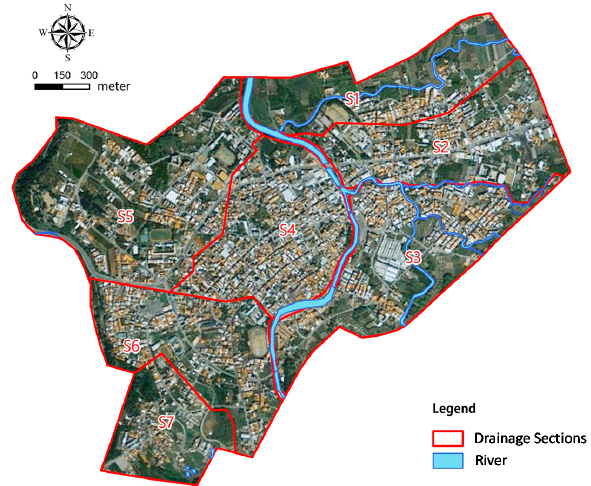
Figure 6. Drainage divisions on city scale.